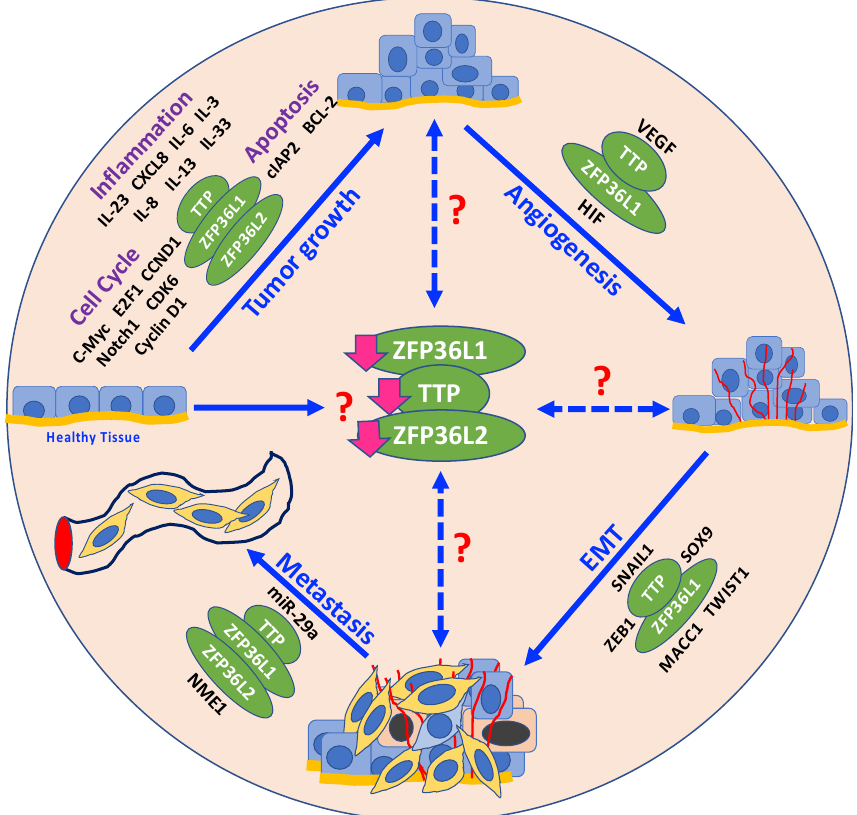
Figure 1. Schematic representation of the various molecular cancer traits that are potentially regulated by TTP family RBPs: TTP family RBPs regulate mRNA targets (shown in black around TTP family RBPs, represented in green ovals) at various stages during carcinogenesis, including tumor growth, angiogenesis, epithelial-mesenchymal transition (EMT), and metastasis. At what stage during the process of carcinogenesis does the loss of expression (downward pink arrows) of TTP family RBPs occur remains unknown (red question mark alongside downregulated expression of TTP family RBPs in the center of the figure). For example, it is possible that normal cells undergo loss of TTP family RBPs expression under the influence of an unknown stressor, thus driving tumor initiation or complementing the effects of the driver genes. Conversely, it is possible that loss of TTP family RBP expression occurs at subsequent stages after initial tumor formation, thus accelerating tumor progression and promoting tumor aggressiveness. Broken bidirectional arrows with red question marks represent this possibility.